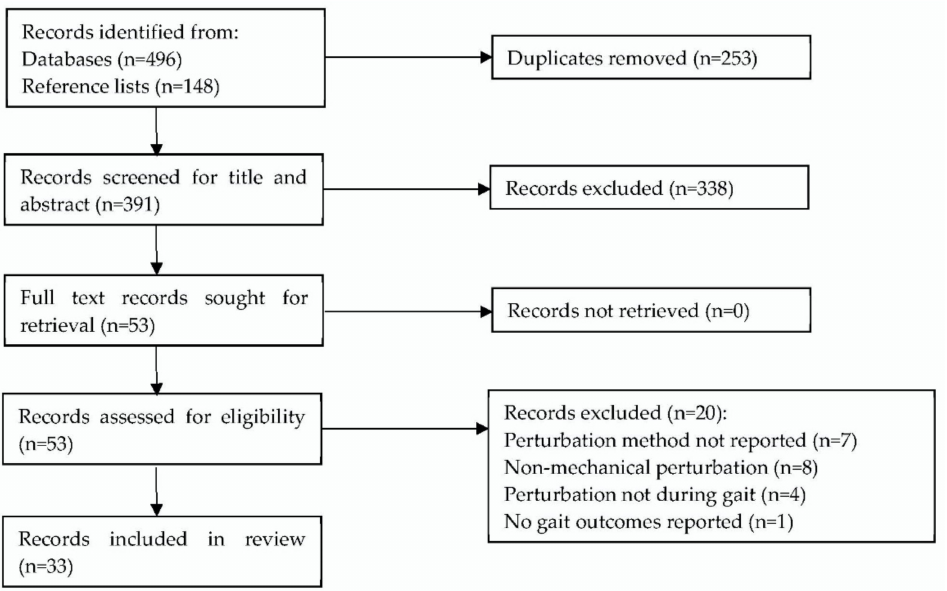
Figure 1. PRISMA flow diagram of search and exclusion criteria